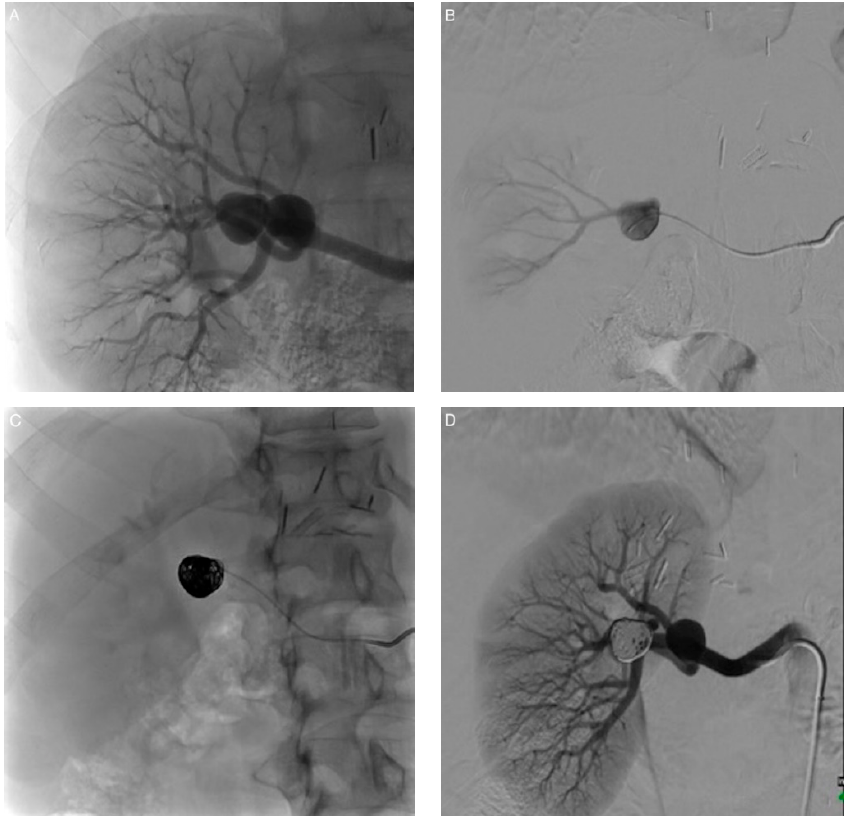
Figure 2. Exclusion of aneurysm 7 by packing embolization. ( A ) Angiogram revealing the two aneurysms. ( B ) Preliminary angiogram performed after selective aneurysm sac catheterization. ( C ) Coil embolization. The aneurysm is fully packed with detachable microcoils. ( D ) After coil embolization, renal artery angiogram shows complete obliteration of the sac with no residual flow or neck.